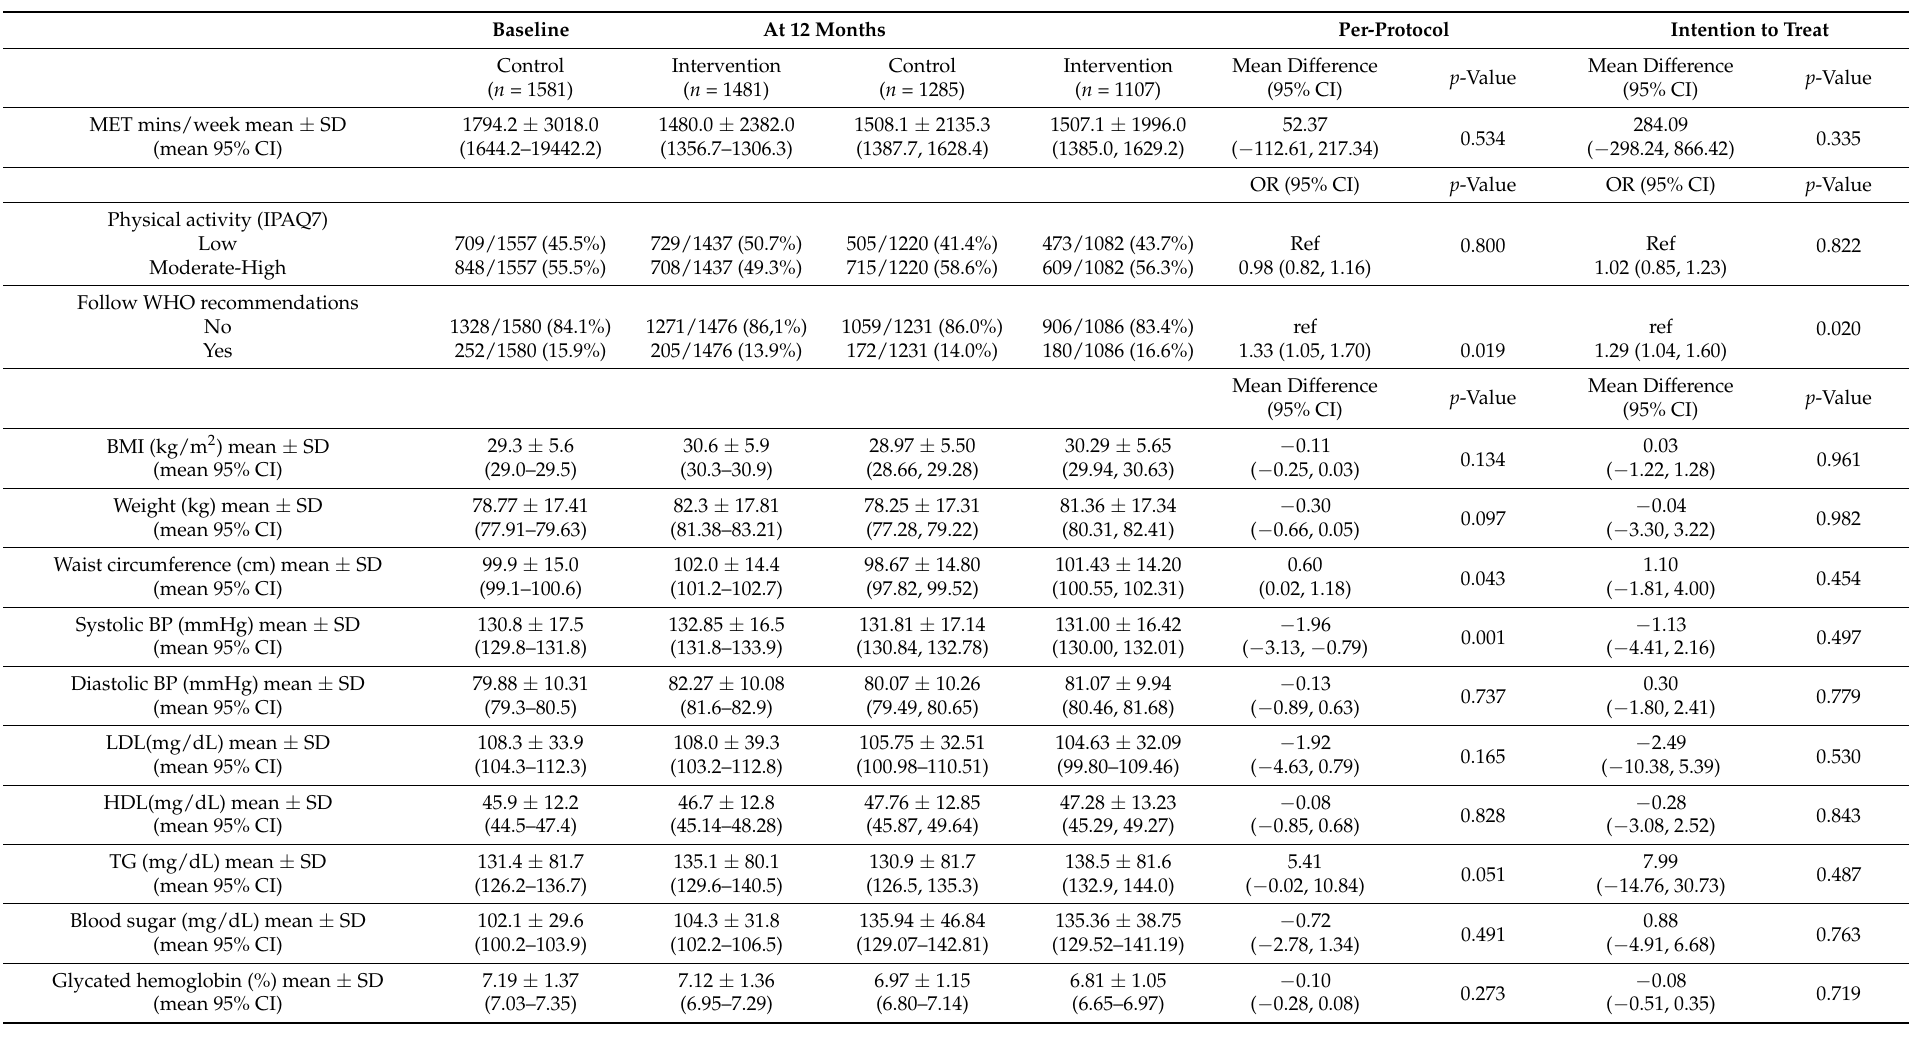
Table 2. Effect of the multiple health behavior change intervention based on per-protocol and intention-to-treat